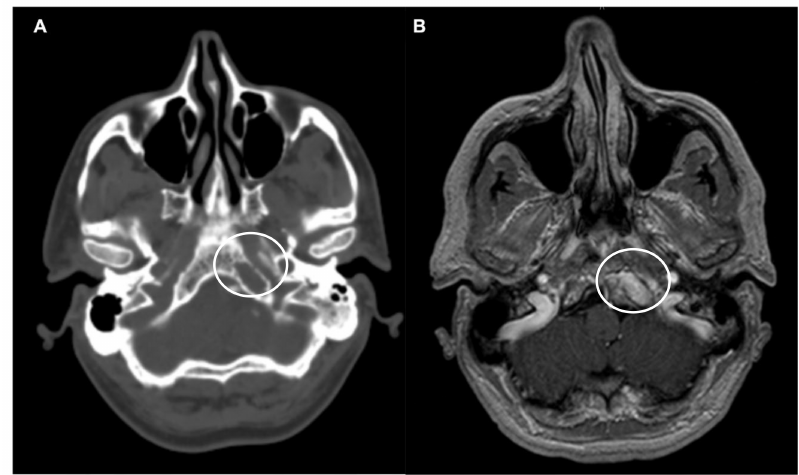
Figure 2. Lower clivus solitary plasmacytoma. ( A ) Axial CT scan showing a lytic expansile lesion at the left lower clivus (circle). ( B ) Axial T1-weighted after contrast injection image showing a heterogenous and hyperintense lesion (circle). A minimally invasive endoscopic endonasal biopsy disclosed the